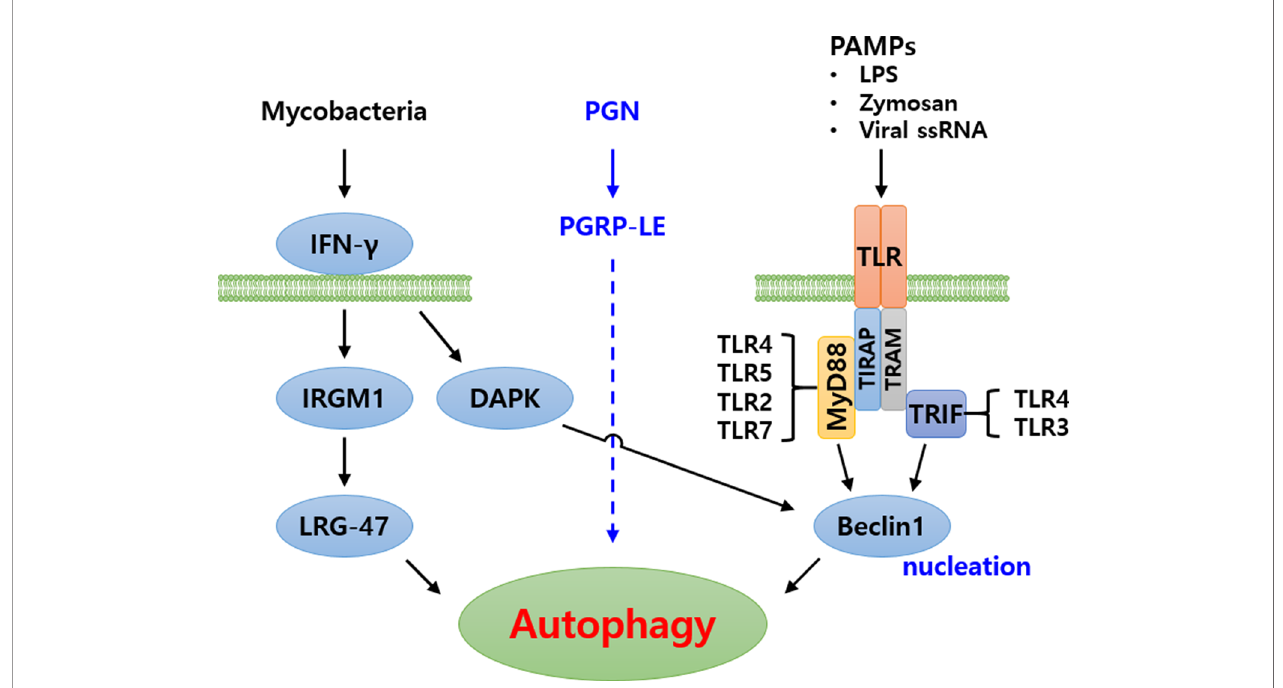
FIGURE 3 | Schematic representation of autophagy signaling cascade induced by pathogenic bacteria in humans. Three major signaling cascades have been identi fi ed. In the fi rst, Mycobacteria are recognized by IFN- g , subsequently inducing autophagy. In the second, bacterial peptidoglycans (PGN) are recognized by PGRP-LE and induce autophagy. The signaling cascade is yet to be identi fi ed. In the third cascade, Pathogen associated molecular patterns (PAMPs) are recognized by Toll-like receptor forming Toll-MyD88-TIRAP complex or Toll-TRIF-TRAM complex, intracellularly. These complexes subsequently signal to Beclin1 (Atg6) for induction of